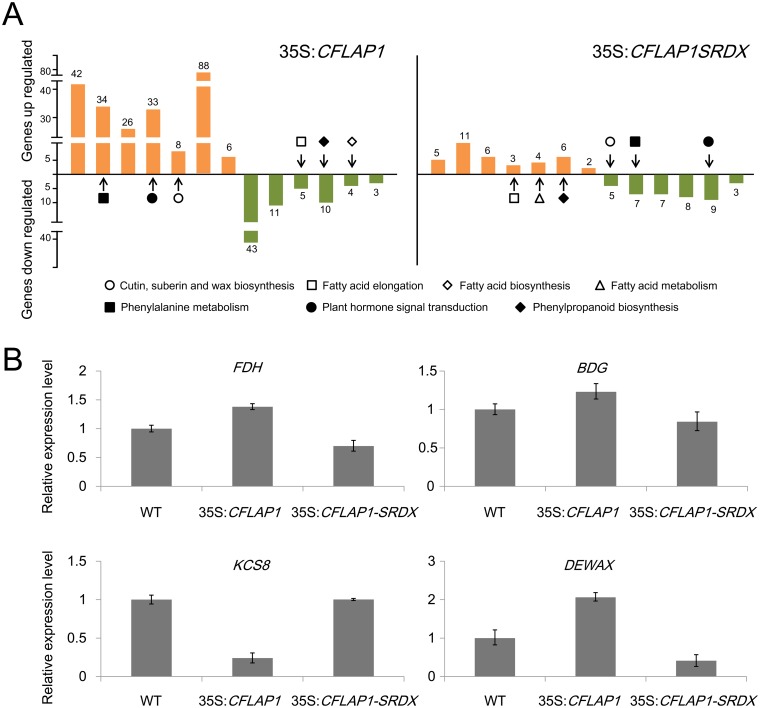
Lipid-related pathways were oppositely regulated in 35S:CFLAP1 plants and 35S:CFLAP1SRDX plants.(A) The orange columns indicate the numbers of the up-regulated genes mapped to the enriched pathways. The green columns indicate the numbers of the down-regulated genes mapped to the enriched pathways. Detailed information was further shown in Tables 2 and 3. Arrows highlight similar pathways with opposite expression trends in 35S:CFLAP1 plants and 35S:CFLAP1SRDX plants. (B) Relative expression levels of FDH, BDG, KCS8 and DEWAX in wild type, 35S:CFLAP1 and 35S:CFLAP1-SRDX plants. The expression level in wild type is set to 1.0. The error bars represent the SD of three biological replicates.